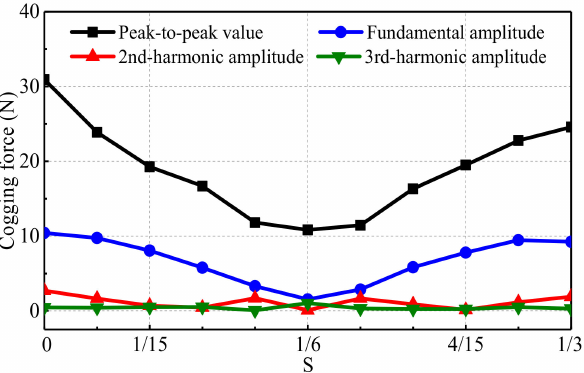
Figure 10. Harmonic amplitudes of the cogging forces varying with different S .